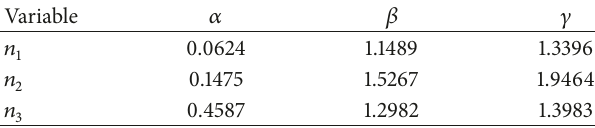
Table 3: Parameter value of evolution model. Figure 1: Steady state of industry-university-research collaborative innovation system (0 input).